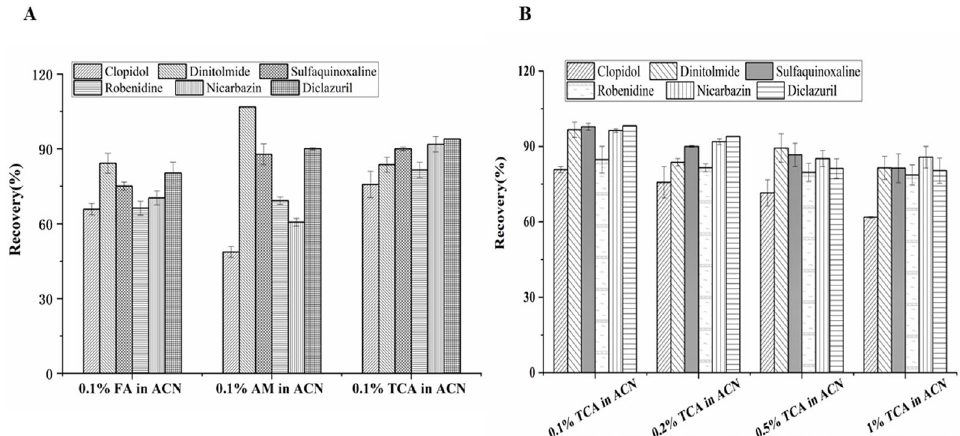
Figure 2. Effects of ( A ) different kinds of extraction solvents and ( B ) various concentrations of TCA in ACN on recoveries of target compounds, with the abbreviation defined as the follows: TCA, trichloroacetic acid; ACN, acetonitrile; FA, formic acid; AM, ammonium (n = 3).